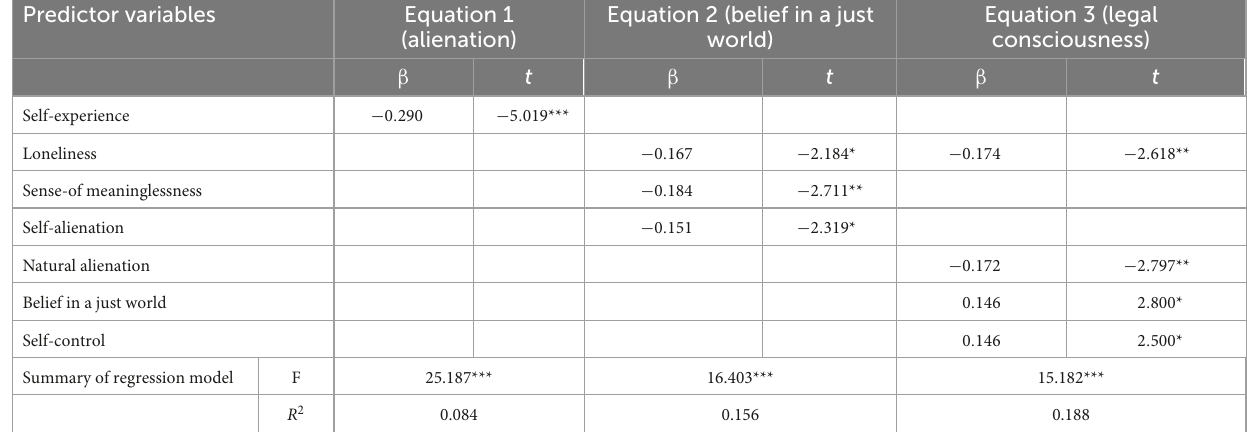
TABLE 5 The stepwise regression analyses of juvenile delinquencies each dimension of self-consciousness, belief in a just world, alienation, and legal consciousness. Predictor variables